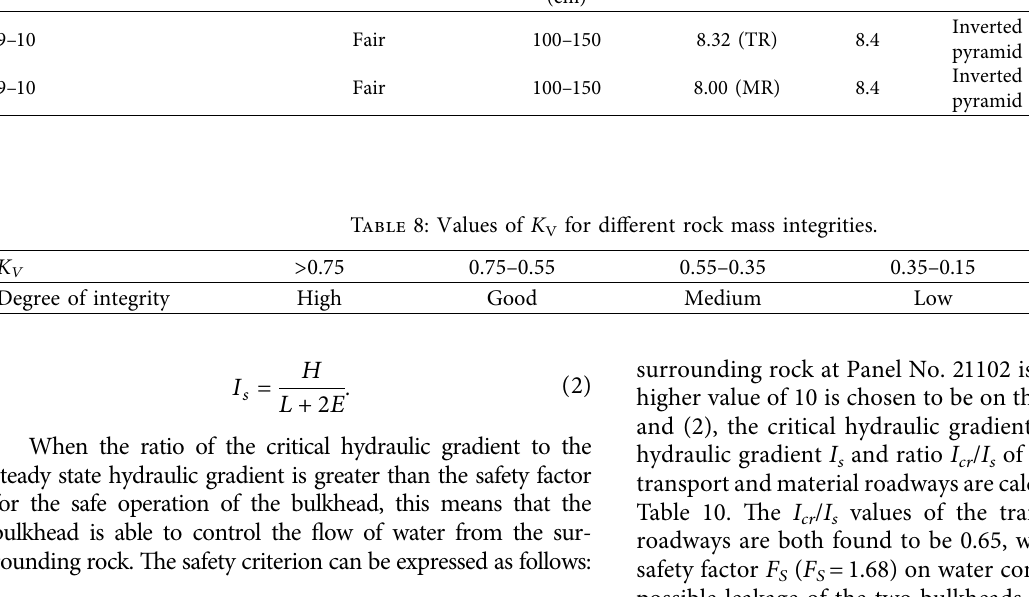
Table 7: Connectivity coefficients of water conducting pathways of fractures in fractured zone of surrounding rocks of Panel No. 21102. Connectivity coefficient of water conducting pathway m